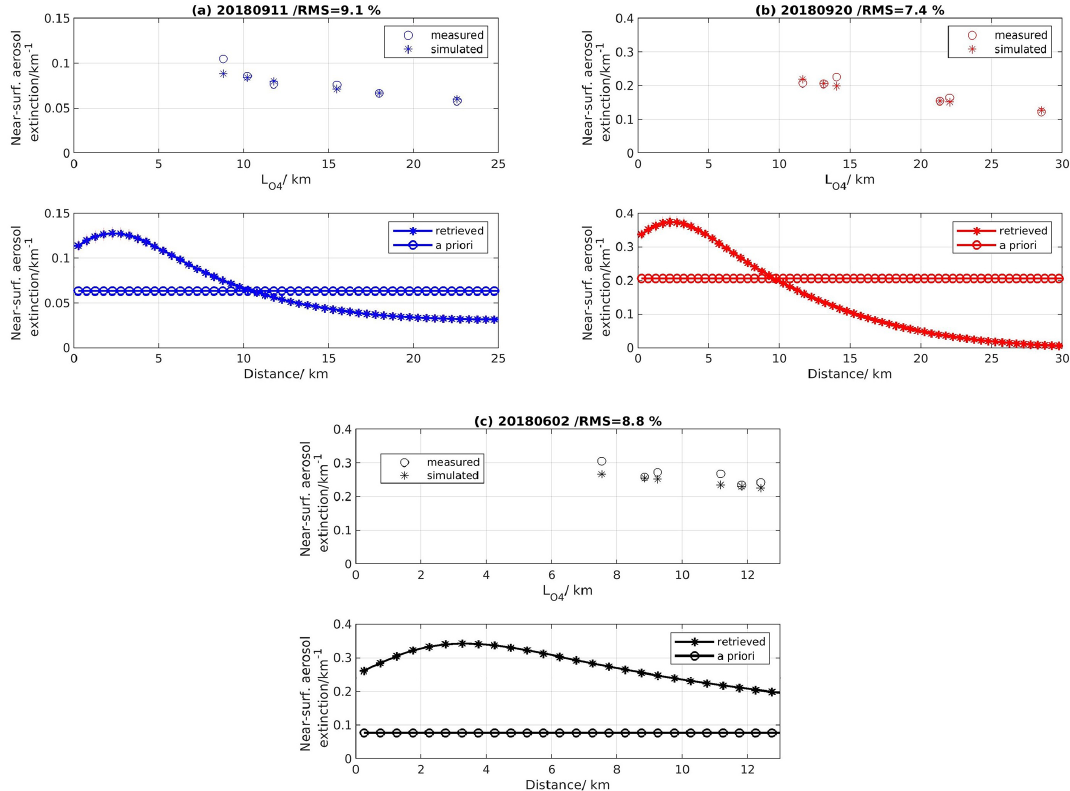
Figure 14. Measured and retrieved near-surface aerosol extinction (upper panels in a , b , and c ) at the six different wavelengths (i.e., horizontal distances) as a function of the estimated horizontal distances and (lower panels in a , b , and c ) the retrieved near-surface aerosol extinction horizontal profile. The panels correspond to (a) 11 September 2018 at 11:48UTC with a 167.5 ◦ azimuthal direction, (b) 20 September 2018 at 07:08UTC with a 25 ◦ azimuthal direction, and (c) 2 June 2018 at 18:16UTC with a 35.5 ◦ azimuthal direction.